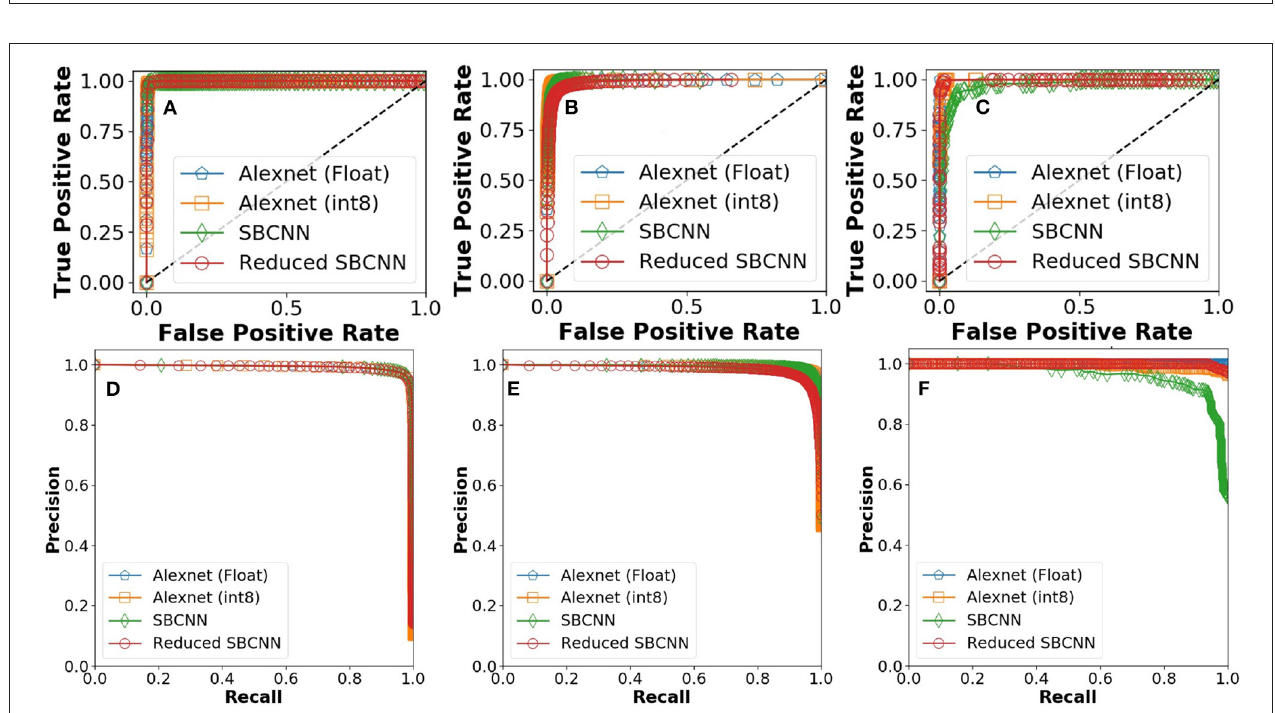
FIGURE 9 | Receiver operating characteristics (ROC) curves for proposed stochastic binarized convolutional neural network (SBCNN):(normal distribution and reduced layers): (A) Malaria, (B) tuberculosis, and (C) intestinal parasite. Precision recall curves for proposed SBCNN (normal distribution and reduced layers): (D) Malaria, (E) tuberculosis, and (F) intestinal